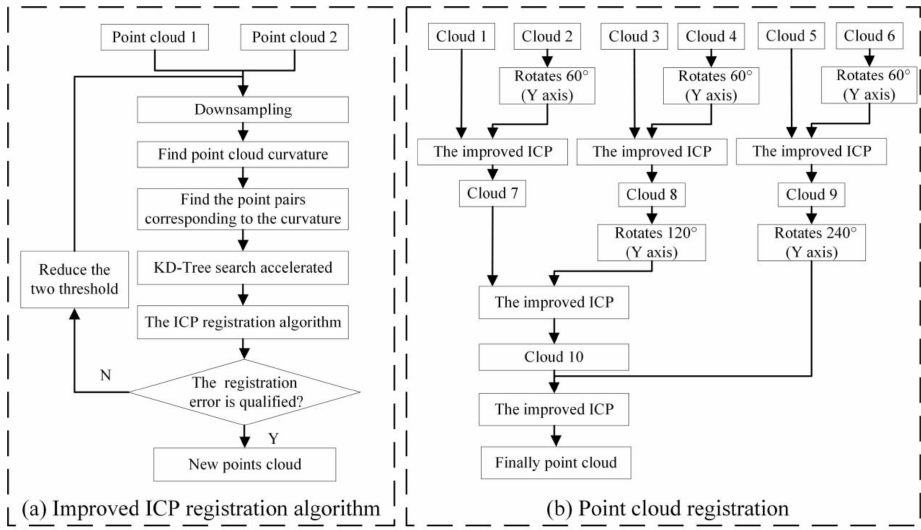
Figure 4. Flow chart of the point cloud registration. ( a ) Improved ICP registration algorithm. ( b ) Point cloud registration of six